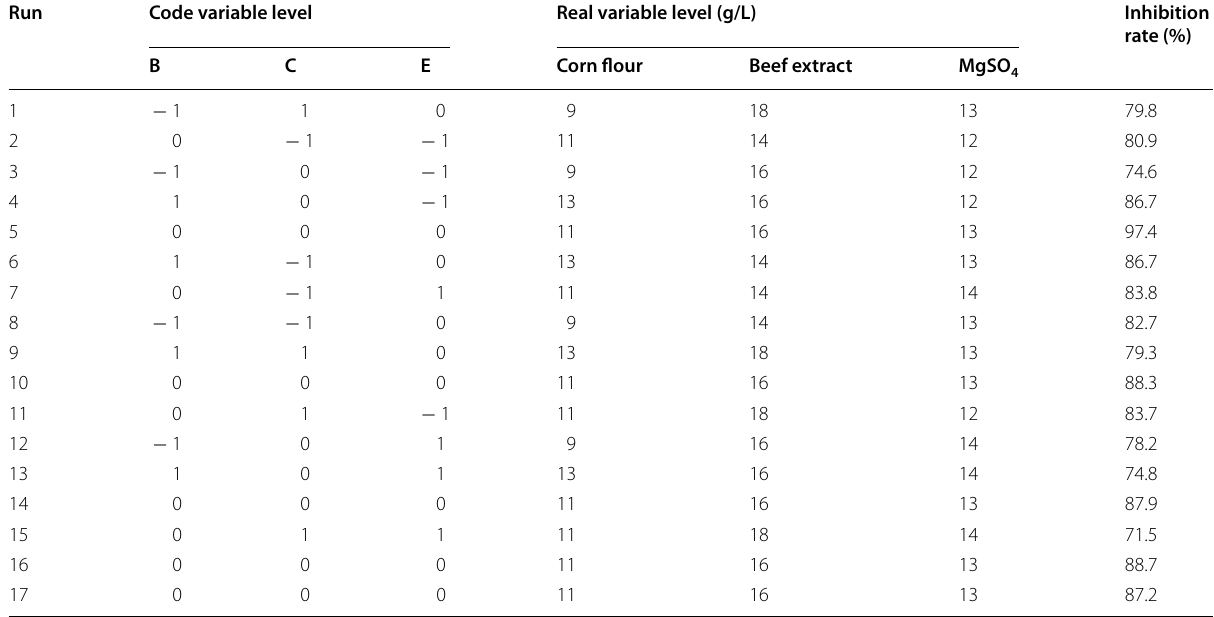
Table 4 Experimental matrix and response values from randomized runs in the Box–Behnken design Run Code variable level